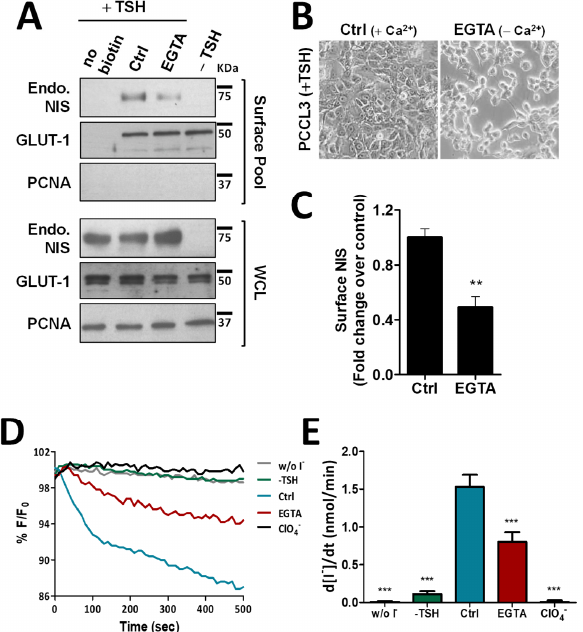
Figure 2. Effect of EGTA-induced AJ disruption on NIS functional expression in non-neoplastic, TSH-responsive thyroid follicular cell line. ( A ) PCCL3 cells subjected to a 24 h starvation period (without TSH) followed by stimulation (or not; − TSH) with TSH (1 mU/mL for 48 h; + TSH), were then additionally treated with either CaCl 2 (1 mM)-containing PBS (Ctrl) or 4 mM of EGTA for 30 min. Endogenous NIS (Endo. NIS) abundance at the PM was assessed by surface protein biotinylation followed by WB using an anti-NIS antibody. Whole-cell lysates (WCL) were also assessed. A replica where cells treated as in ‘Ctrl’ were not incubated with biotin (no Biotin), controlled the specificity of biotinylated protein pull-down. GLUT-1 served as loading control (for densitometric normalization) among cell-surface protein extracts and WCL, whereas PCNA monitored for both WCL loading and eventual intracellular protein contamination in cell-surface extracts. ( B ) Representative images of AJs disruption of PCCL3 cells treated for 30 min with either CaCl 2 (1 mM)-containing PBS (Ctrl) or calcium-free PBS containing 4 mM of EGTA. ( C ) Surface NIS abundance was quantified by densitometry analysis of WB bands, using ImageJ software. Plotted values are means ± SEM of three independent assays. Comparisons to each corresponding control condition were made using a two-tailed Student’s t -test (** p ≤ 0.01). ( D ) Traces of HS-YFP fluorescence decay of HS-YFP-PCCL3 cells treated as in ( A ) after exposure to 1 mM NaI, in the presence or absence of ClO 4 − (1 mM, 10 min). YFP fluorescence was recorded continuously, as described in the legend to Figure 1. ( E ) Iodide influx rates were calculated by fitting the curves to the exponential decay curves. The data are the means ± SEM of five independent assays. The significant variations were assessed by one-way ANOVA (F = 49.97; p < 0.001) followed by Dunnett’s post-hoc test, as compared with the control conditions (Ctrl) (*** p < 0.001). The uncropped bolts are shown in Supplementary Materials File